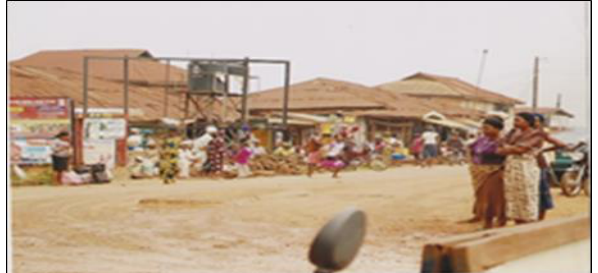
Figure 3. Case study market showing agricultural product display section. (Source: Field work, 2015)